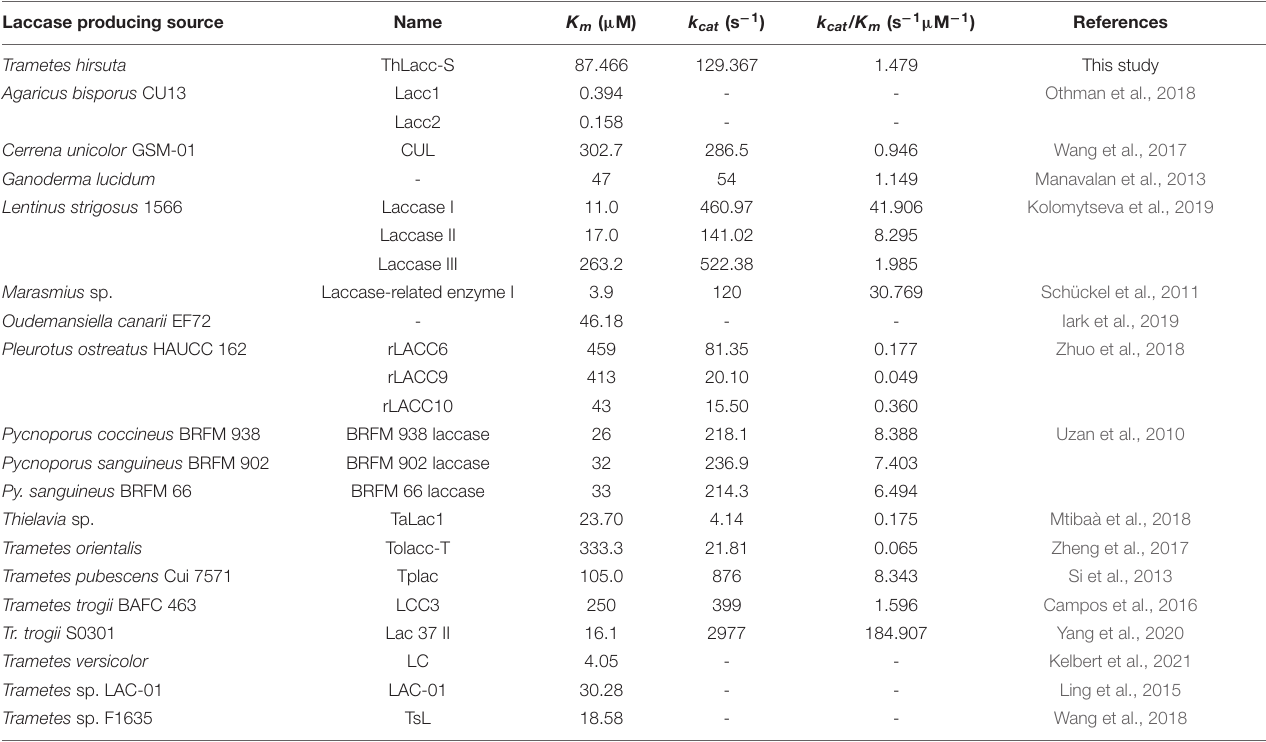
TABLE 3 | Comparisons of the kinetic parameters of laccase ThLacc-S from Trametes hirsuta with those of other reported laccases. Laccase producing